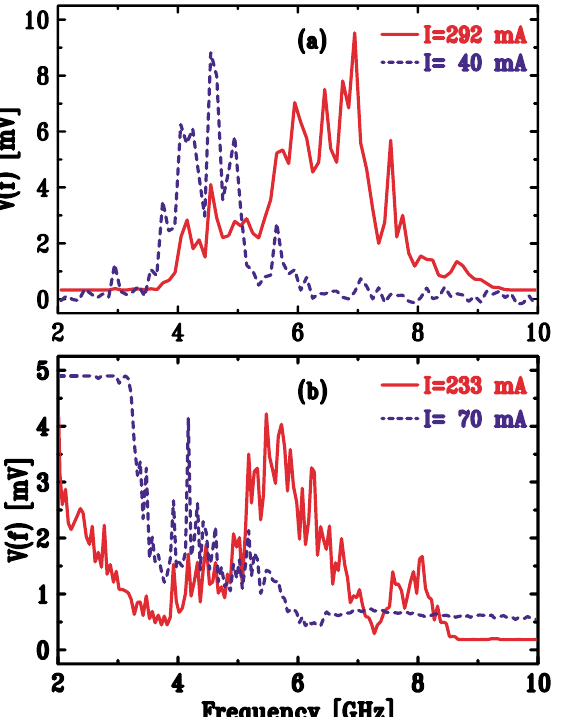
FIG. 7. (Color) (a) Peak A (positive) and C signals on a long and (b) detailed time structure of the time scale for I > I t power